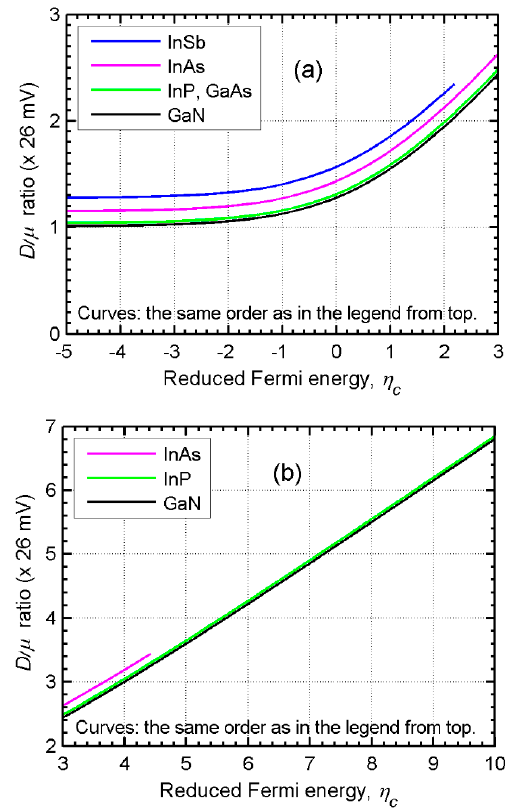
Figure 4. Calculated values of the D / μ ratios for conduction electrons as a function of the reduced FE for common direct-bandgap compound semiconductors at T L = 300 K. The plot ( a ) is for η c < 3; and the plot ( b ) for η c > 3.